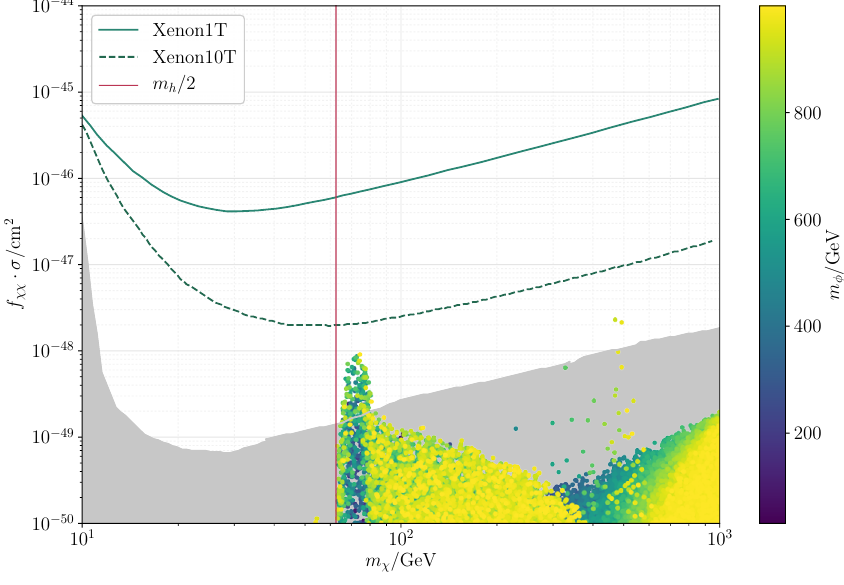
Figure 10 . The effective SI-DM nucleon cross section versus the DM mass m χ is shown, where the color code indicates the value of the non-SM like Higgs boson mass m φ . The gray shaded region denotes the neutrino floor background and the lines the respective (expected) limits of the different experiments. The vertical red line corresponds to m χ = m h / 2